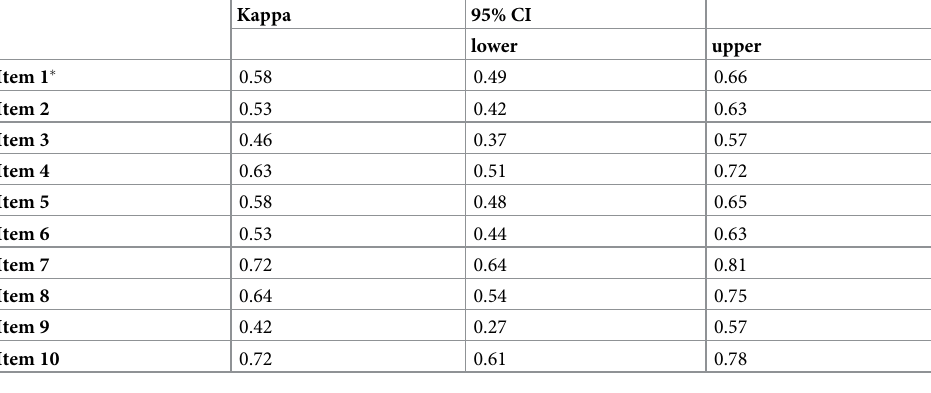
Table 2. Kappa coefficients of single item test-retest of the STarT-MSK G